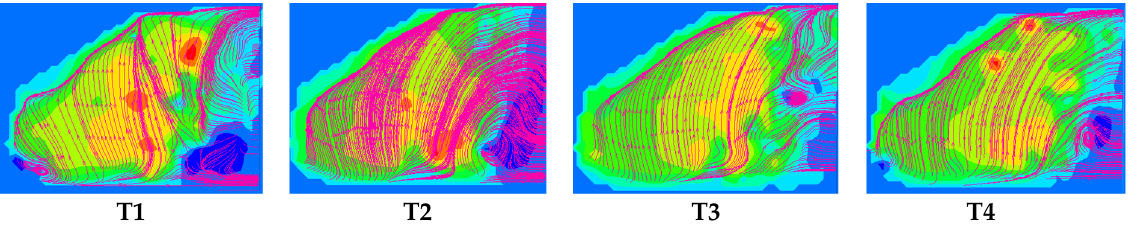
Figure 9. Incipient vortex conditions at high unit speeds.T1–T4 is the moment of shooting.